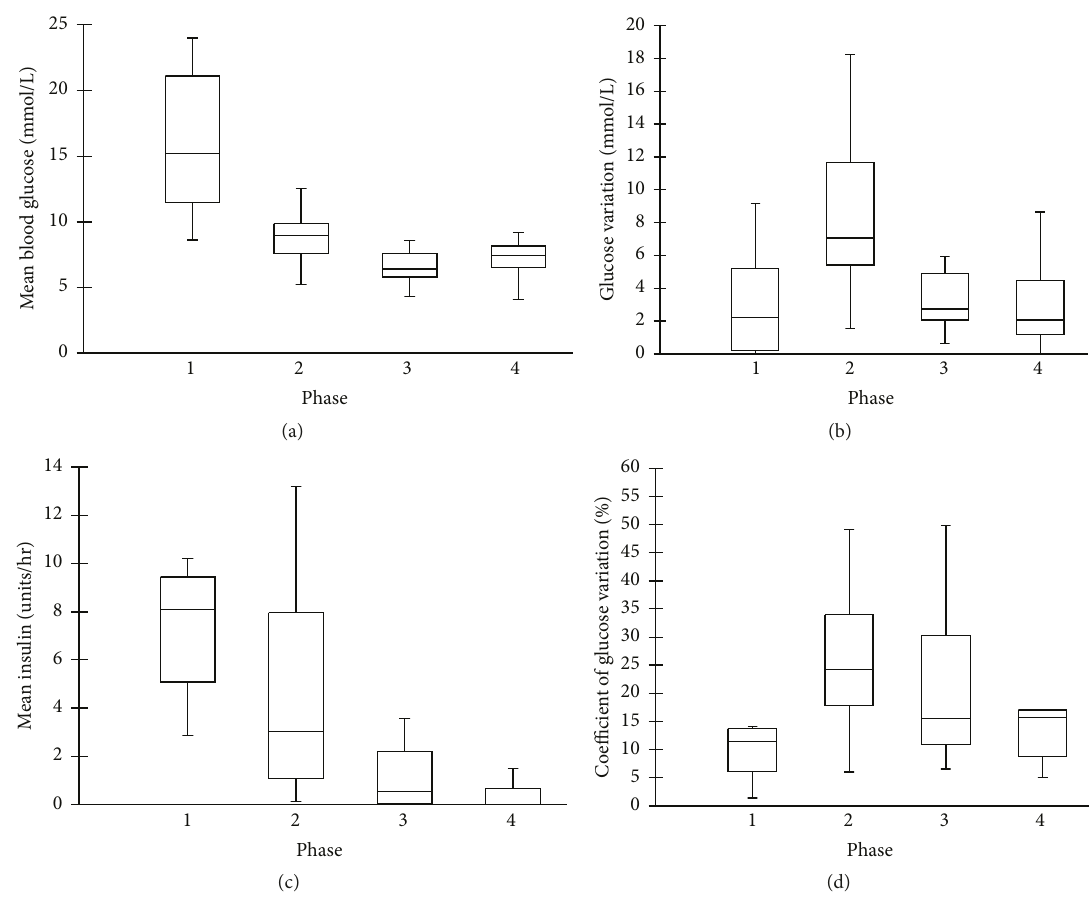
Figure 2: Average glycemic parameters per phase. The lines within the boxes represent medians, the boxes represent the 25th and 75th percentiles, and the whisker lines represent the 5th and 95th percentiles. (a) Mean blood glucose (BG) per phase (mmol/L). 𝑝 < 0.001 . (b) Glucose variability (mmol/L) = BGmax − BGmin per phase, 𝑝 = 0.001 . (c) Mean insulin dose per phase (units/hr), 𝑝 < 0.001 . Data only available for nine patients for Phase 1 due to out-of-hospital cooling. (d) Percentage coefficient of glucose variation (%) = BG standard deviation/BG mean ∗ 100 per phase, 𝑝 = 0.097